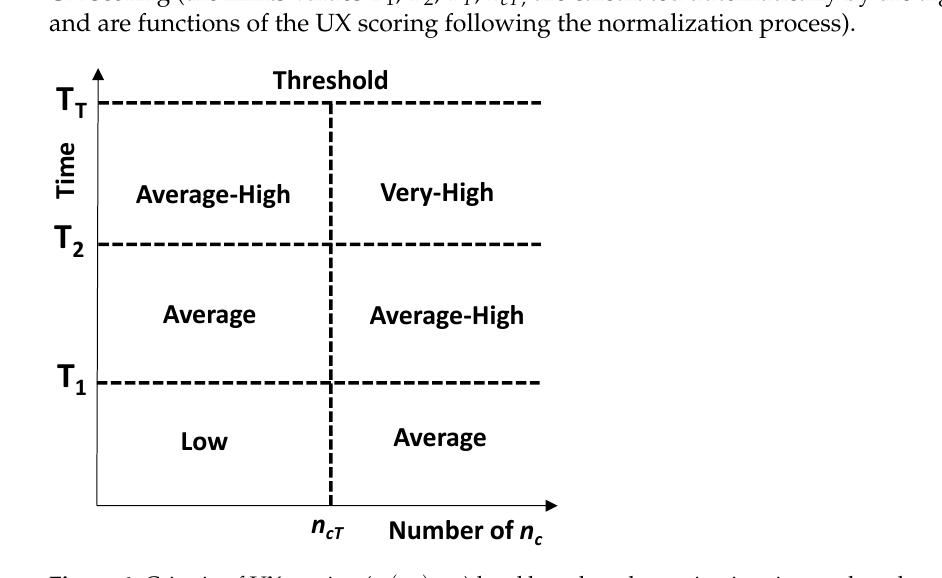
) level based on the navigation time and on the number of user